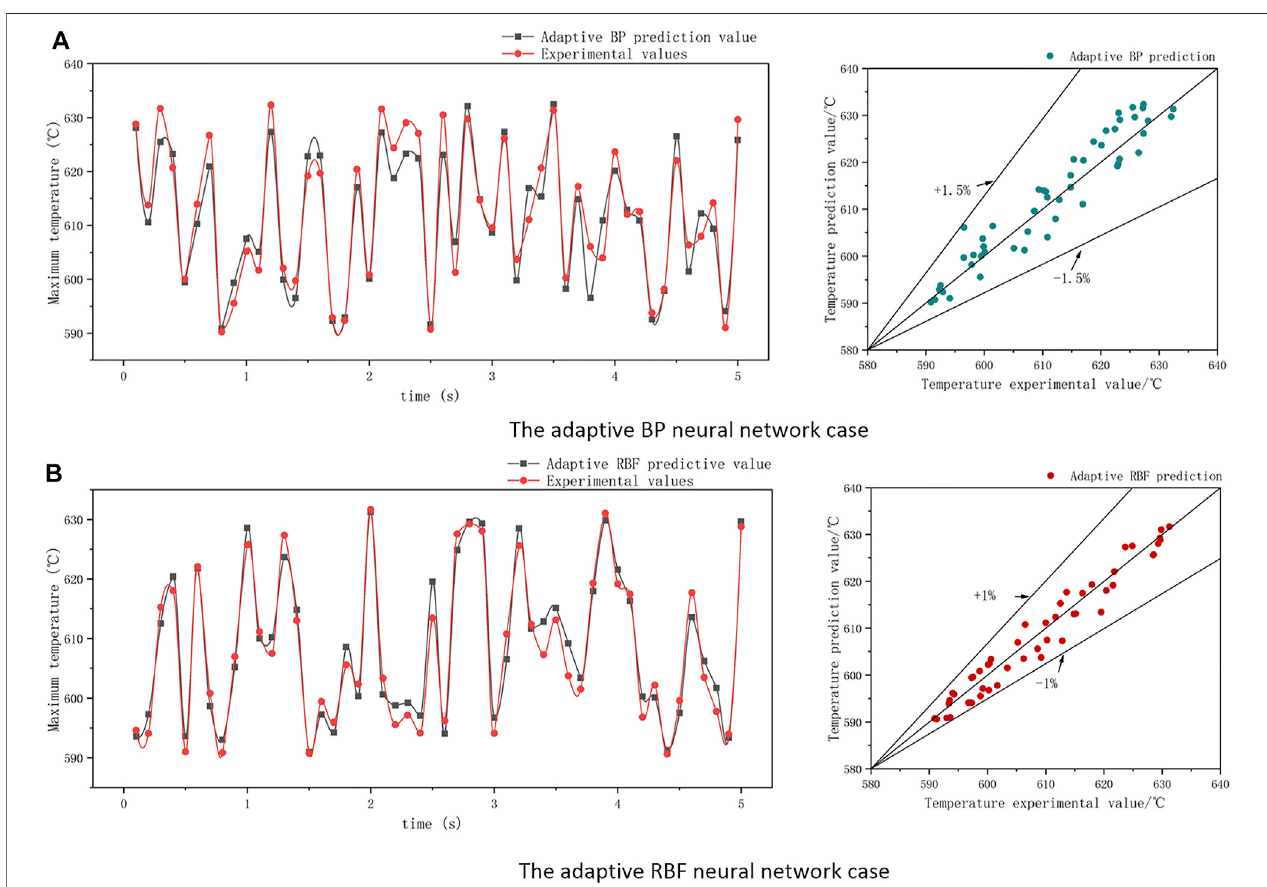
FIGURE 11 | The accuracy comparation between adaptive BP neural network and adaptive RBF neural network.